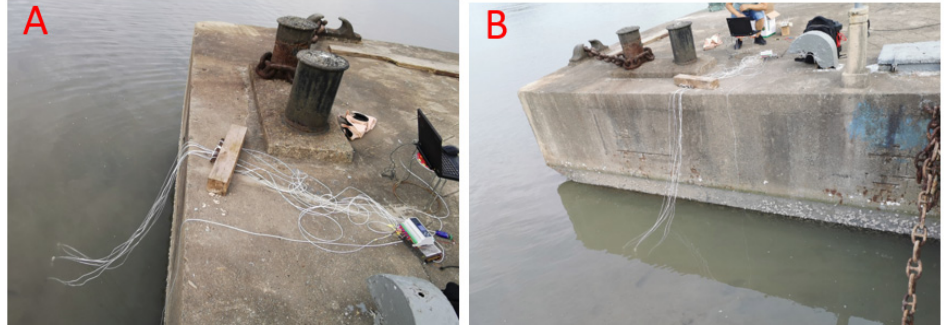
Figure 14. The experimental scene of the seaside shoal. ( A ) photo of the experimental installation on the shore; ( B ) photo of sensor and probe placement.